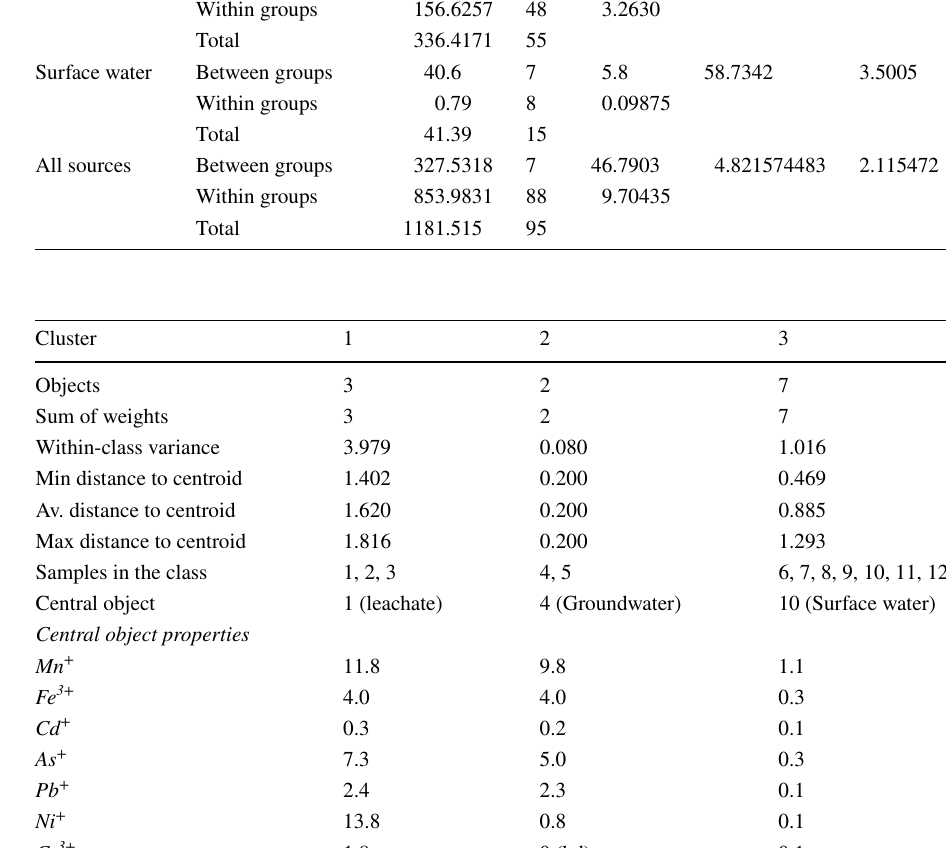
Table 6 ANOVA results of the tested natural water sources